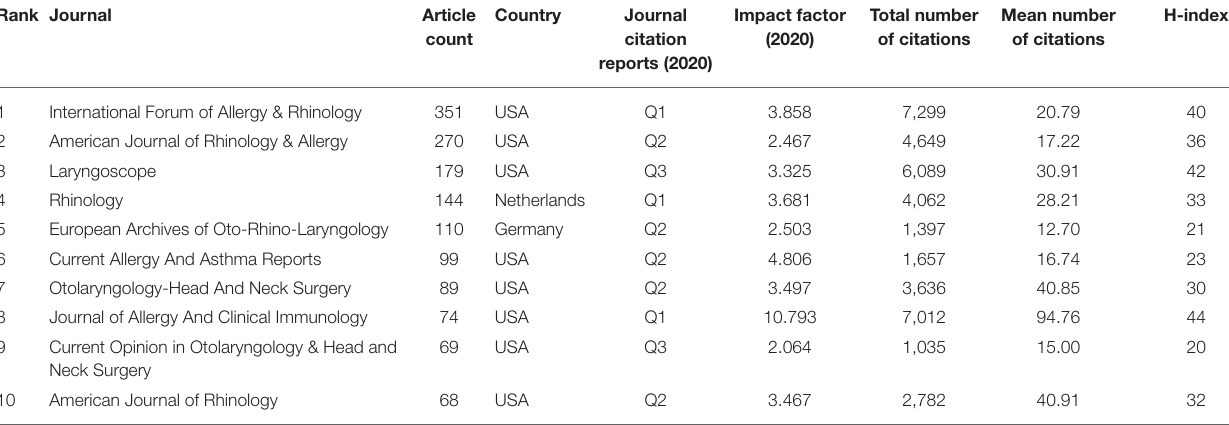
TABLE 4 | Ranking of top-10 journals for the number of articles published on CRS-treatment research from 2001 to 2020. Rank